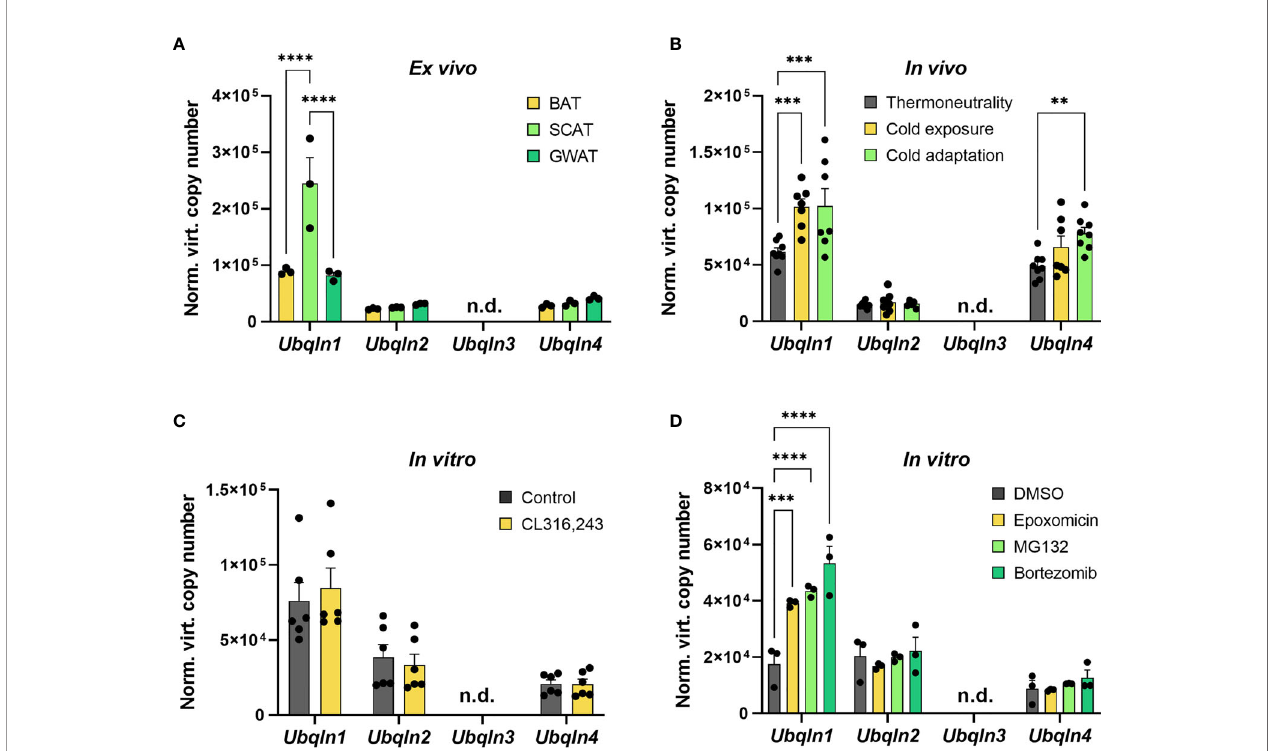
FIGURE 1 | Ubqln1 is highly expressed in adipose tissue and induced by cold & proteasome inhibition. Absolute mRNA expression calculated from Ct values of Ubqln1 , Ubqln2, Ubqln3 & Ubqln4 in (A) Primary adipocytes from BAT, SCAT & GWAT ( n = 3 technical replicates). (B) , BAT from mice kept at 30°C for 7 days (thermoneutrality), 4°C for 24 h (cold exposure) and 4°C for 7 days (cold adaptation) ( n = 8 biological replicates). (C) imBAT untreated or treated with 1 µM CL316,243 for 6 h (n = 6 technical replicates from 2 independent experiments). (D), imBAT treated with DMSO (control), 100 nM epoxomicin, 100 nM MG132